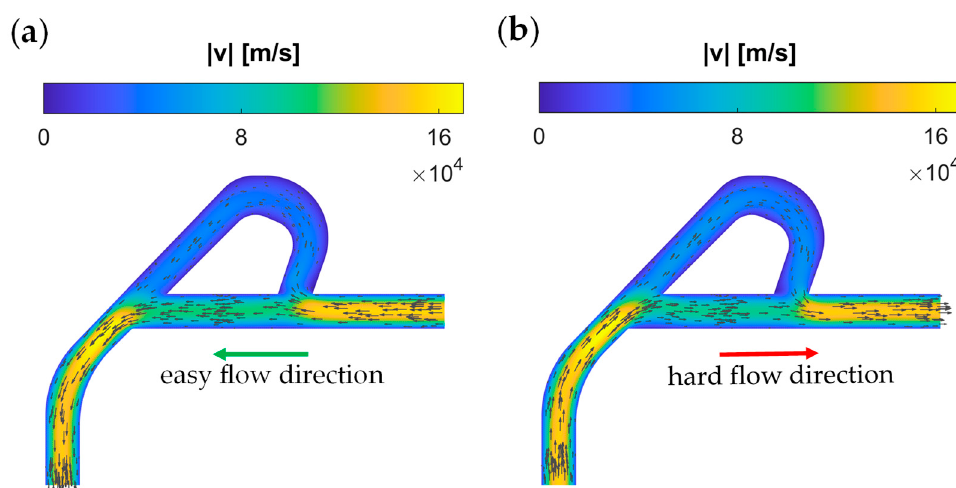
Figure 3. Hydrodynamic electron flow demonstrated in graphene Tesla valve. ( a ) Electron flow from right contact to the left, due to higher (50 mV) potential on the left; easy and less-resistive direction for the hydrodynamic flow. ( b ) Electron flow toward the right contact, harder and more resistive path for electrons, due to viscosity effects and momentum-loss, due to the large angle at the connection of the branches. The small difference in velocities causes the rectification effect (see the diodicity analysis below in the text).